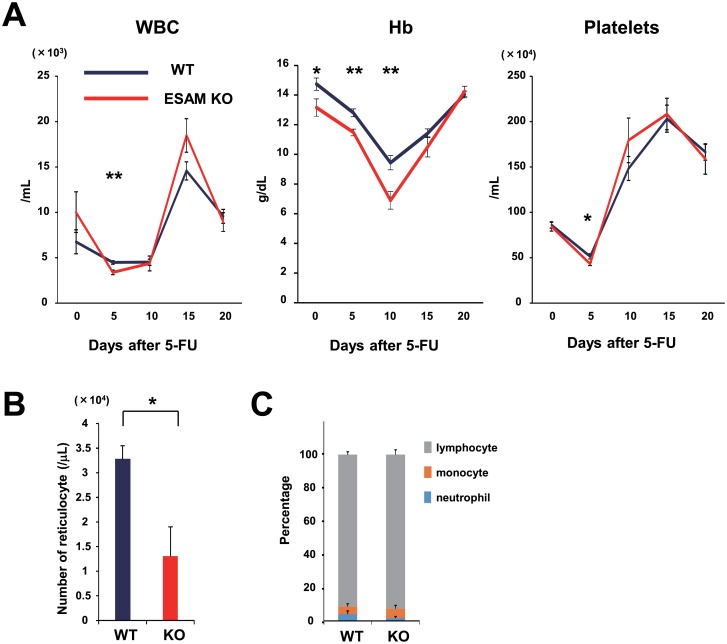
ESAM deficiency caused serious and prolonged anemia after 5-FU treatment.(A) WT or ESAM-KO mice were intravenously administered with a single 200 mg/kg dose of 5-FU to then examine the PB every 5 days (up to day 20) using a blood cell analyzer (KX-21, Sysmex) (n = 10 in each). WBC, Hb, and platelet counts were plotted. Two ESAM-KO mice died between day 10 and day 15 after 5-FU treatment. (B, C) WT or ESAM-KO mice were administered 150 mg/kg of 5-FU and PB analyses were performed at day 8. (B) The number of reticulocytes were quantified by visual counting (n = 3). (C) The mean percentage of neutrophil, monocyte, and lymphocyte subsets in WBC were quantified by visual counting (n = 3). Data are shown as mean ± SEM. Statistically significant differences are represented by asterisks (*P < 0.05, ** P < 0.01).